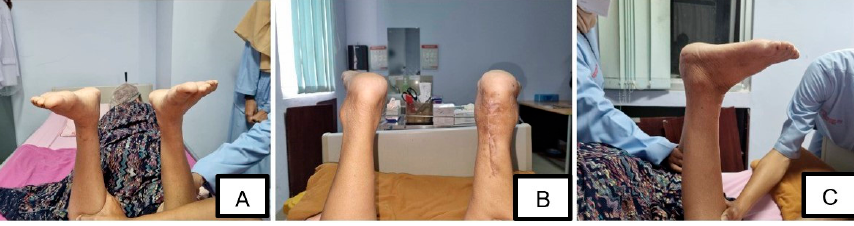
Figure 5. Follow-up condition (one month after the surgery). ( A ) anterior view, ( B ) posterior view, ( C ) lateral view. Note that plantarflexion can be noticed in both limbs (negative Matles test).